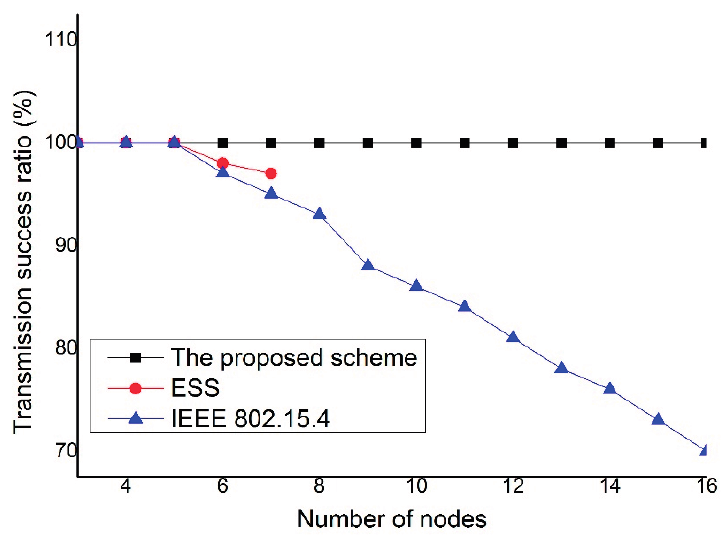
Figure 18. The transmission success ratio versus the number of